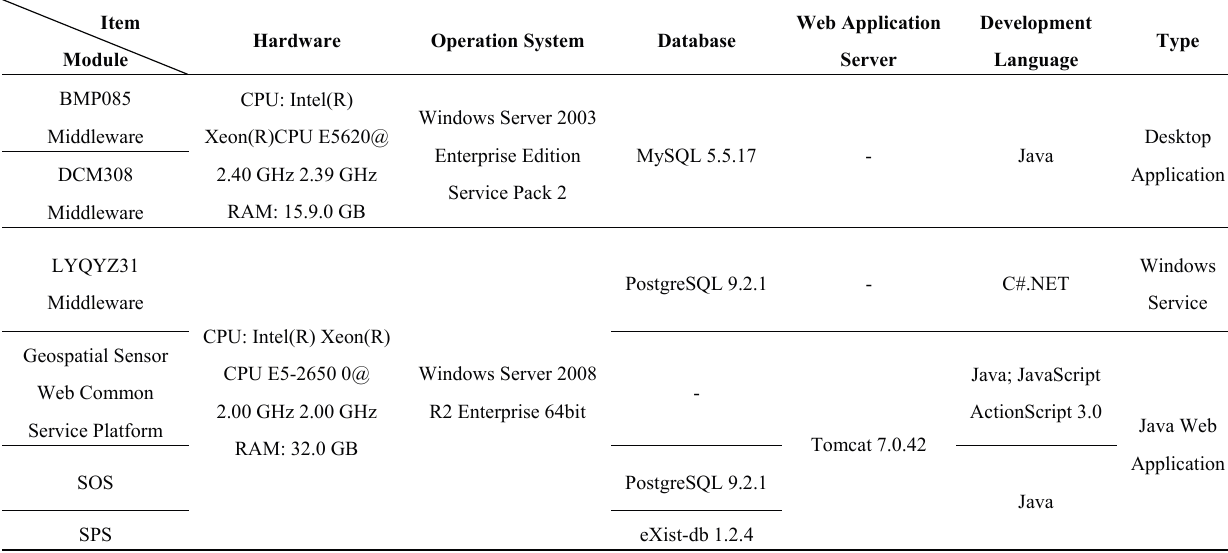
Table 6. Implementation details of Geospatial Sensor Web Common Service